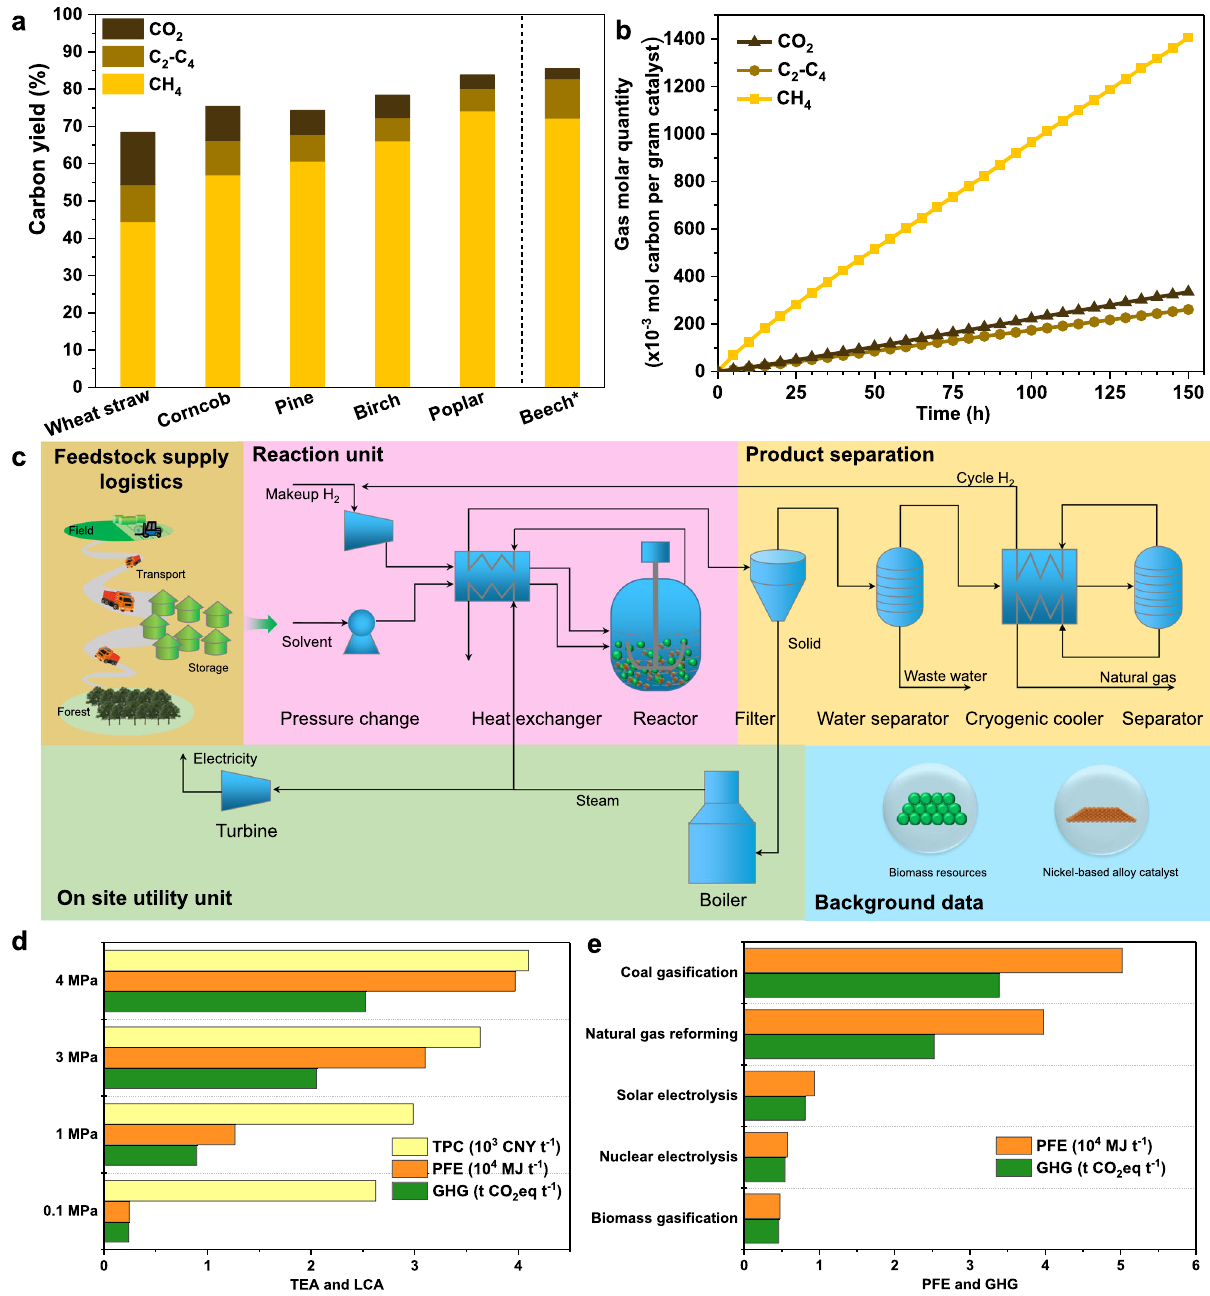
and forestry residues. b Reusability of the catalyst with Ni 2 Al 3 alloy phase. c Conceptual process modeling for bio-natural gas production from biomass. d Effects of hydrogen pressure on TEA and LCA of bio-natural gas. e Effects of hydrogen source on life cycle PFE depletion and GHG emissions of bio- natural gas. Reaction condition: 1.0 g substrate, 5.2 mmol nickel-based alloy catalyst (based on nickel), 20 mL H 2 O, 4 MPa H 2 , 300 °C, 5 h; *10.0 g